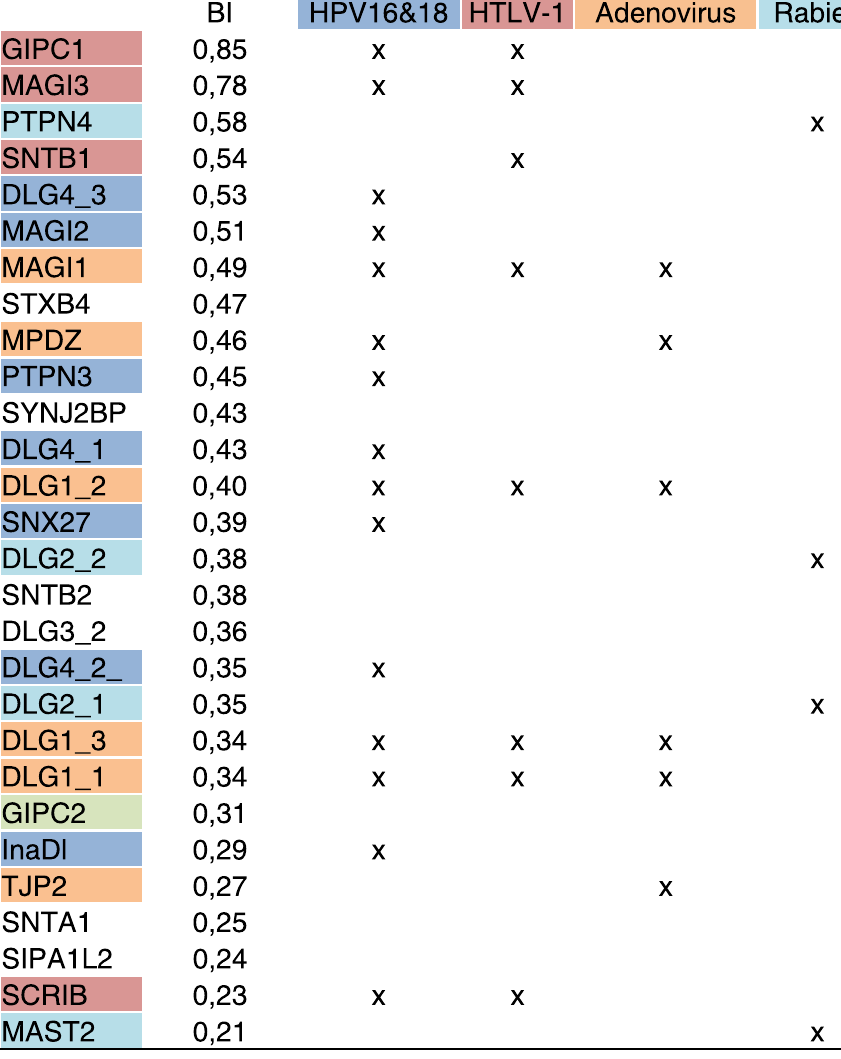
Table 2. Best binders of HBc PBM in the holdup assay. Binding intensities (BIs) and occurrences between HBV and other viruses are